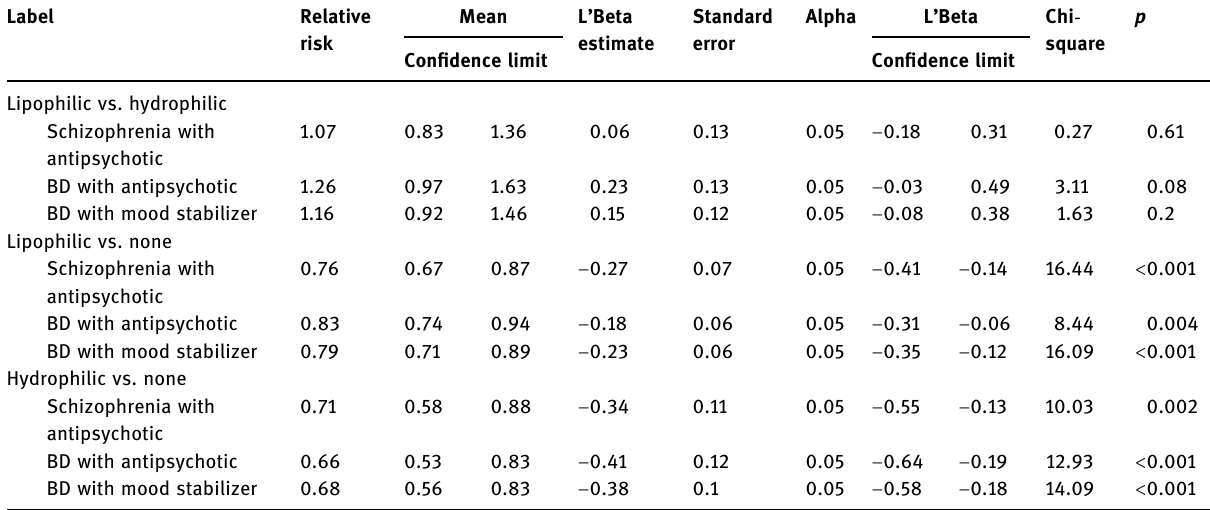
Table 5: Psychiatric emergency department visit in individuals with schizophrenia and bipolar disorder; comparison between lipophilic, hydrophilic, and no statin groups Label